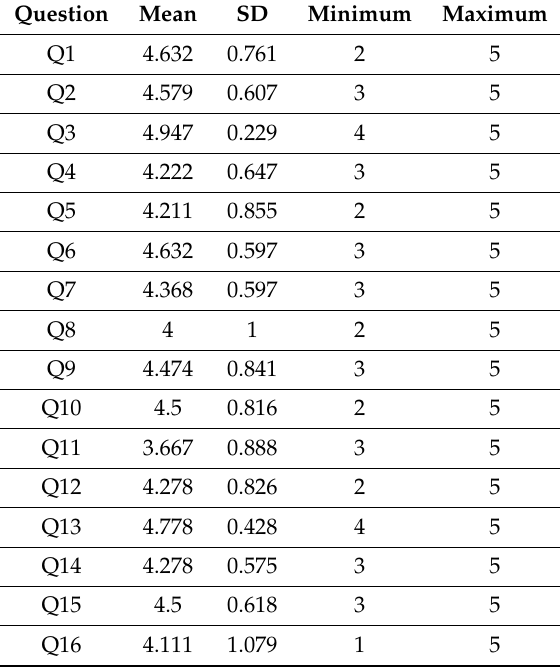
Table 5. Summary statistics per